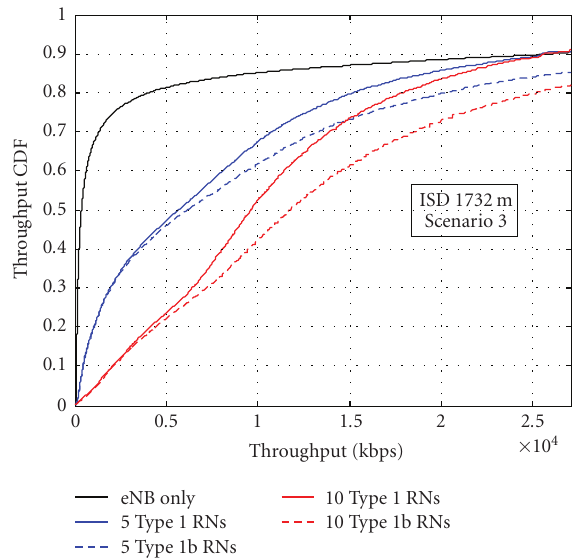
Figure 7: Throughput CDF-Scenario 3, ISD 1732 m.